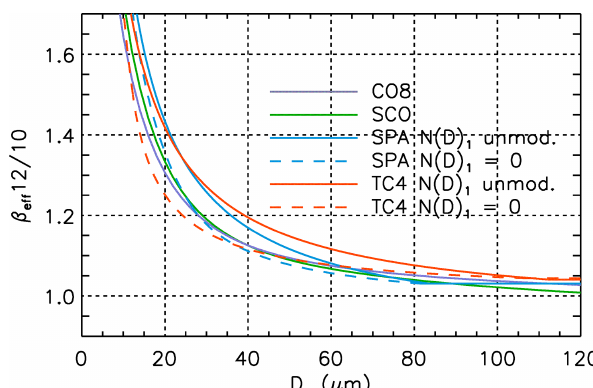
Figure 12. β eff 12 / 10 vs. D e for the V4 LUTs (purple: CO8; green: SCO) and as derived by Mitchell et al. (2018) during the SPARTI- CUS (blue) and TC4 (red) field experiments using N(D) 1 unmodi- fied (solid) or N(D) 1 = 0